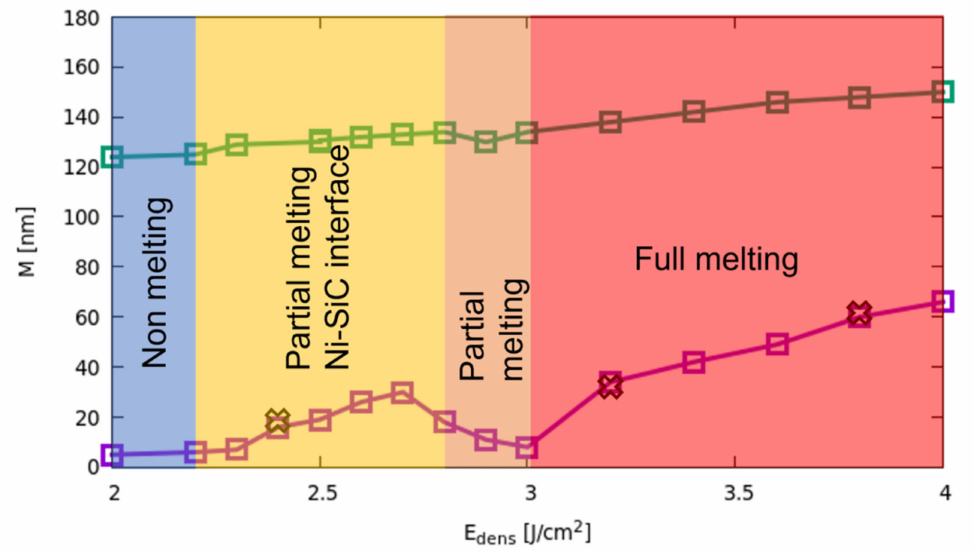
Figure 10. Extension of the Ni-rich layer M Ni-rich ( E dens ) (green line and square) and the extension of the silicide layer M Silicide ( E dens ) (purple line and circles) as a function of E dens . Experimental values from [9], of the silicide layers 18, 36 and 62 nm are also reported as black crosses for the 2.4, 3.2 and 3.8 J/cm 2 cases,